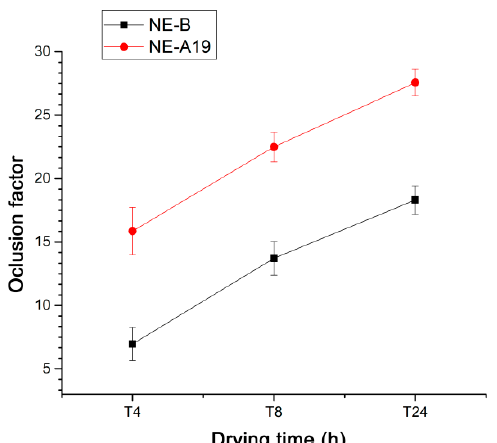
Figure 4. Occlusion factors as a function of the drying time for NE-A19 (red) and NE-B (black) from 4 to 24 h.